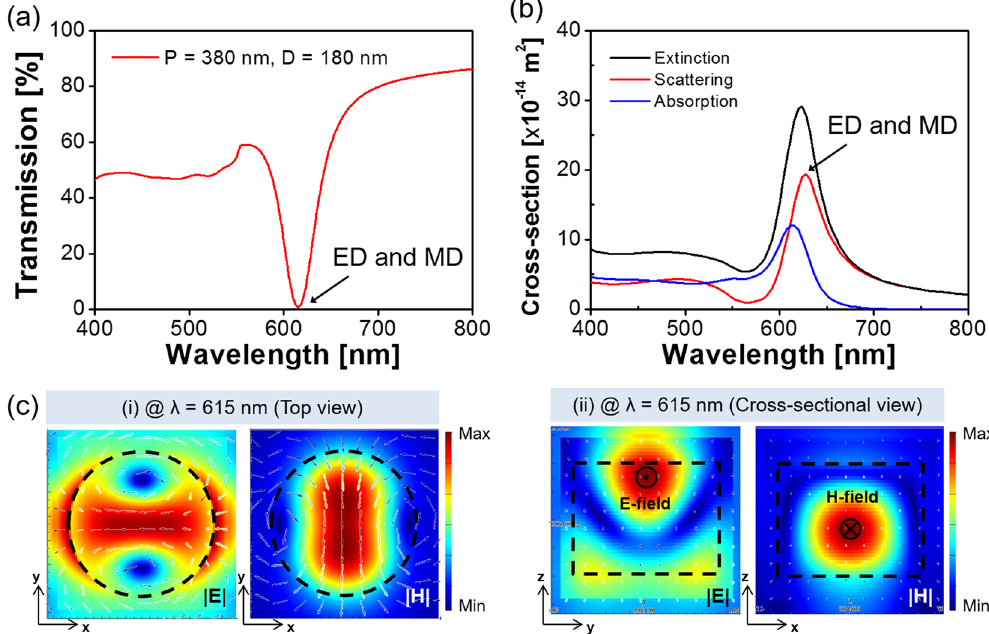
Figure 5. ( a ) Calculated transmission spectra for the metasurface with P = 380 nm and D = 180 nm, exhibiting a single resonance at λ = 615 nm. ( b ) Calculated extinction, scattering, and absorption cross-sections for the a-Si:H nanodisk. ( c ) Resonant field profiles for the unit a-Si:H nanodisk at λ = 615 nm: (i) top view and (ii) cross-sectional view. Both the ED and MD resonances coincide